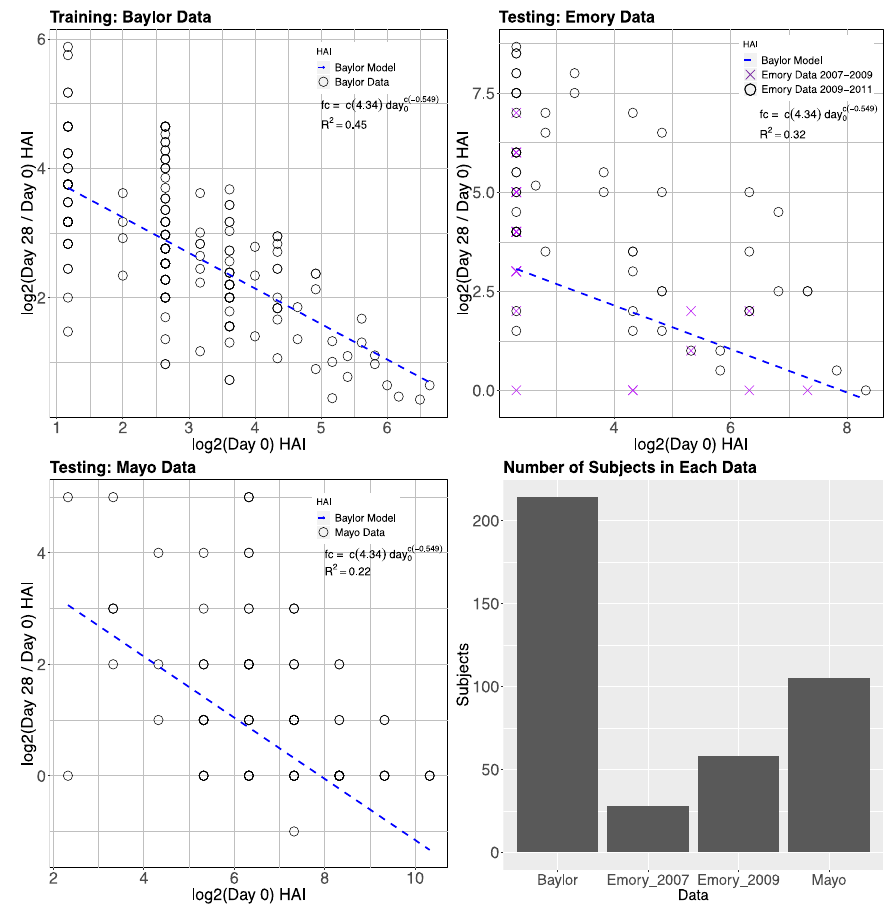
Figure 2. Baseline (day-0) HAI model prediction of HAI fold change (day 28) trained on the Baylor data and tested on Emory and Mayo data. The plots are on log 2 scale, where predicted values are plotted with blue dash line with parameters trained from the Baylor data. The parameters are shown in the model equation along with the R 2 . The variation explained in fold change HAI is 45% in the Baylor data, 32% in the Emory data, and 22% in Mayo data. Emory data are a combination of two data sets from different years that are distinguished by black circles (2007–2009) and purple crosses (2009– 2011).